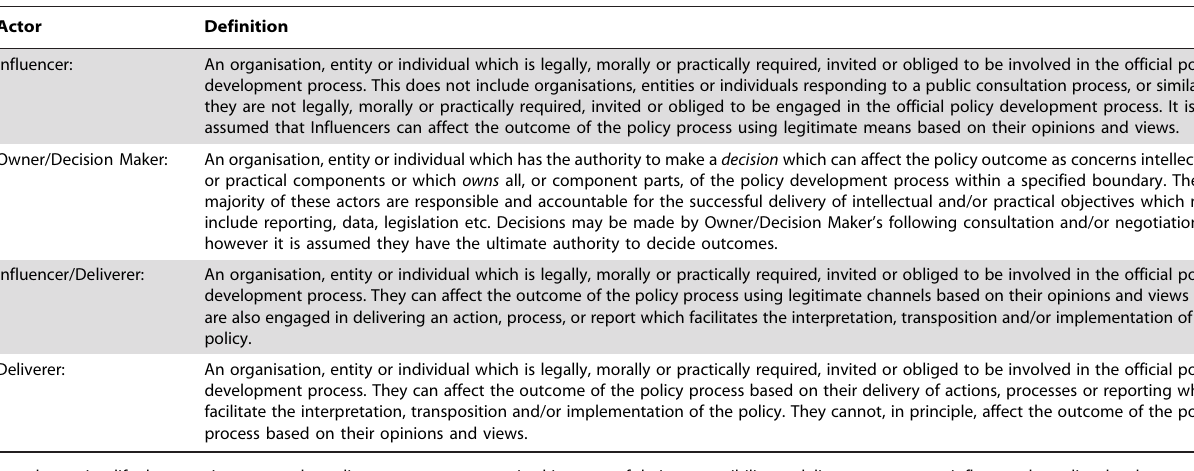
Table 1. Categories of policy actors.